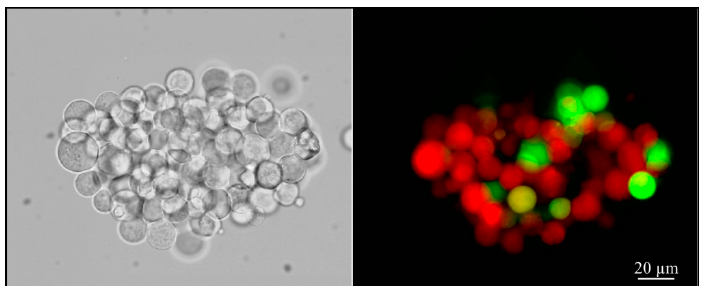
Figure 2. Representative photomicrograph of HEK293T cells transduction by internalization of pseudoviruses into ACE2-HEK293 cells. The enhanced green fluorescent protein (eGFP) is expressed upon integration into target cells (panel on the right). The fluorescence was recorded at 54 h post-transduction. Magnification 200×.